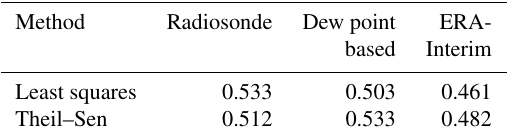
Table 1. Comparison between the estimated trends (mmdecade − 1 ) from radiosonde, dew-point-based, and ERA-Interim PWV time se- ries at site Lindenberg. The standard error of the estimated trend is ≈ 0.04mmdecade − 1